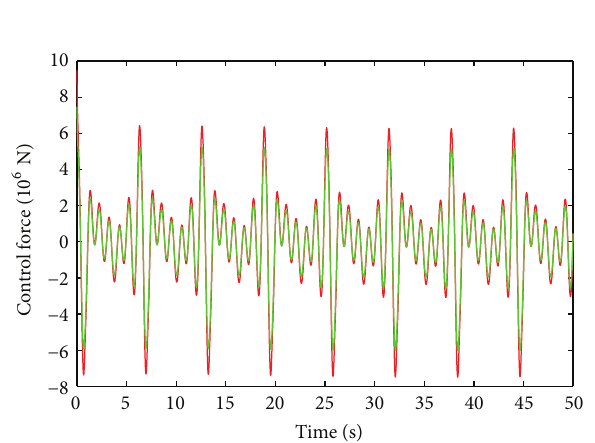
Figure 5: Velocity curves.